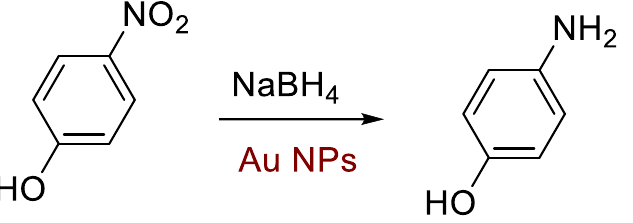
Figure 3. Reusability tests on HMF oxidation using two catalysts prepared with either a synthesized or a commercial polymer. Reaction conditions: T = 70 °C, t = 2 h, P = 10 bar O 2 , molar ratios HMF:Au:NaOH = 1:0.01:4.